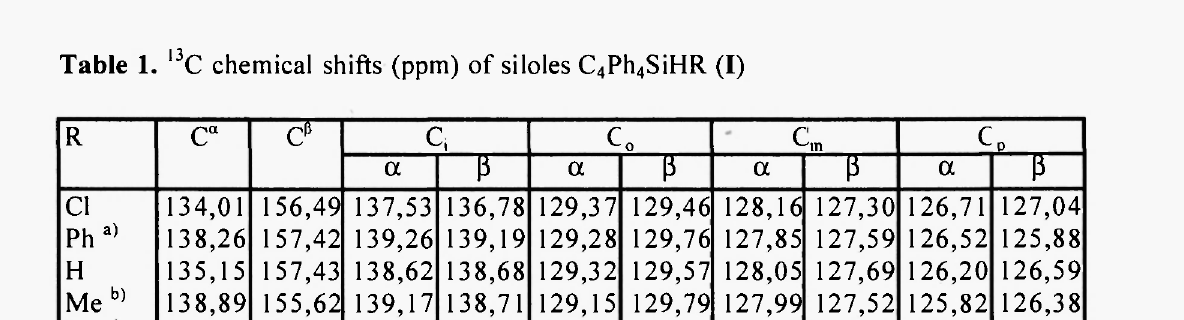
Table 1. 13 C chemical shifts (ppm) of siloles C 4 Ph 4 SiHR (I)